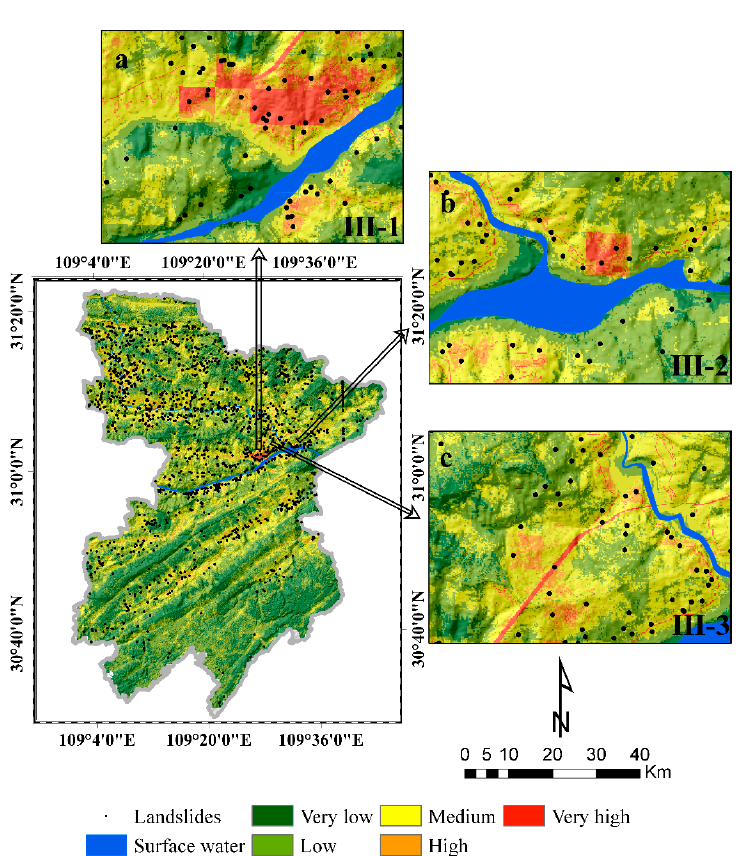
Figure 17. Key prevention area for landslide hazard. ( III-1 ) in the eastern Yongan Town and the western Zhuyi Town, ( III-2 ) in the Chenjiabao landslide, Guanmiaotuo landslide and Linjiawan landslide, ( III-3 ) in the central urban section of Hurong Expressway.